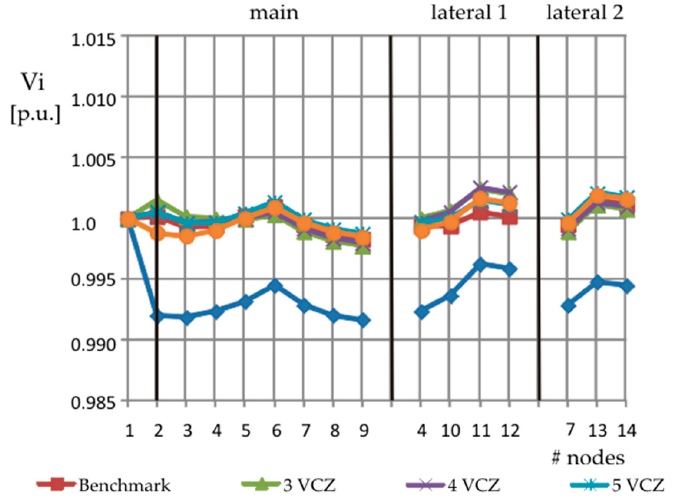
Figure 9 : Voltage profiles for Case R — DG and BESS : Q algorithm—feeder 1.